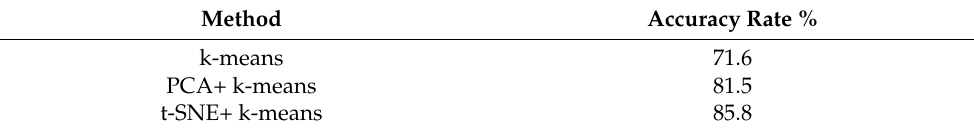
Table 3. Identification result